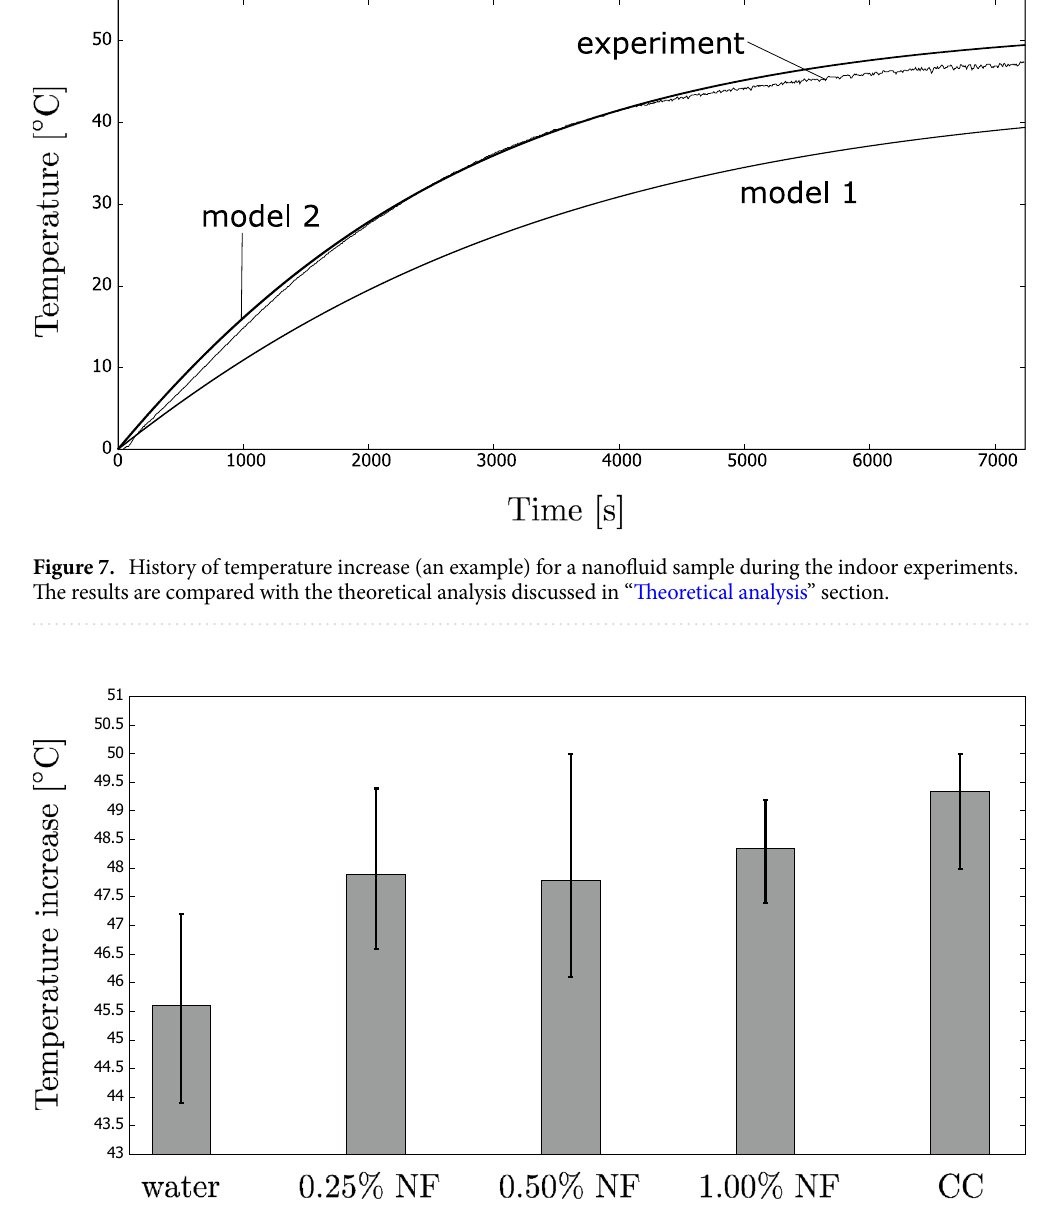
Figure 8. The temperature increase for different fluids involved in the indoor experiments (NF: nanofluid; CC: coffee colloid). All the fluids (except for distilled water) result in a similar